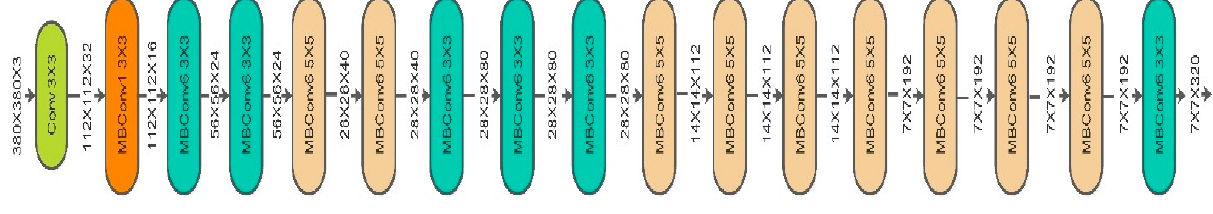
Figure 6. The architecture of E ffi cientNet-b0 [40] .